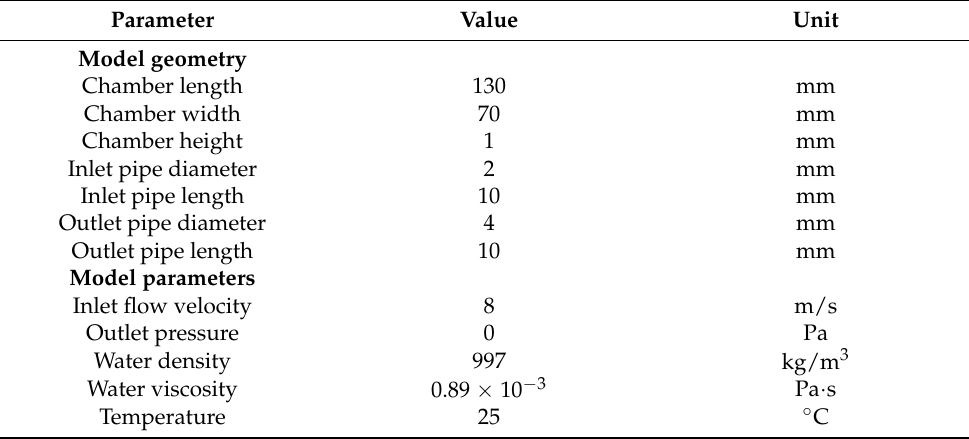
Figure 3. Three-dimensional schematic view of the computational domain. Table 1. Numerical model parameters.